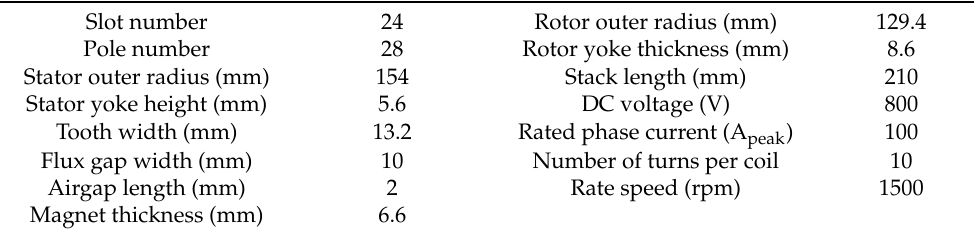
Figure 3. ( a ) Torque and ( b ) losses vs. speed for the modular and non-modular machines.